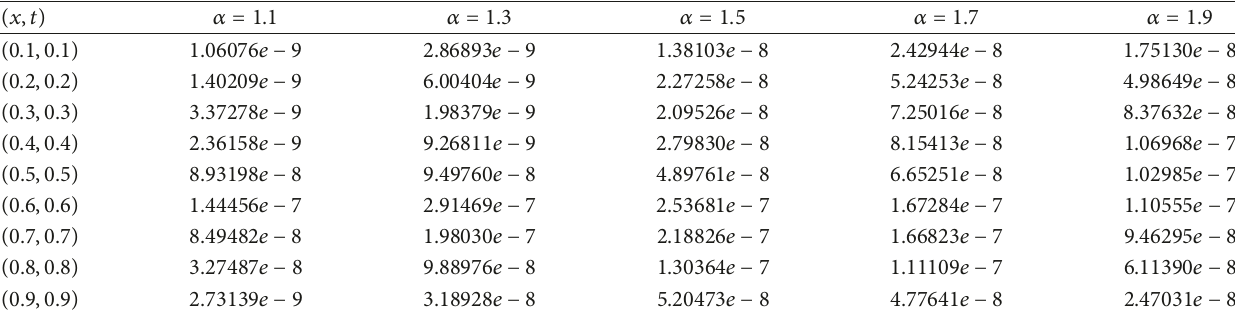
Table 8: The absolute errors for Example 4 for some different values 1 < 𝛼 ≤ 2 at some different points.